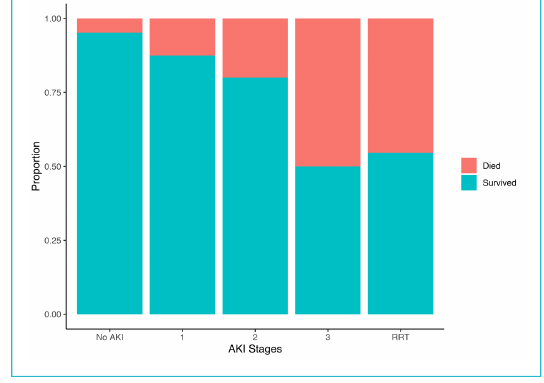
Figure 2: Mortality according to stage of acute kidney injury (AKI).